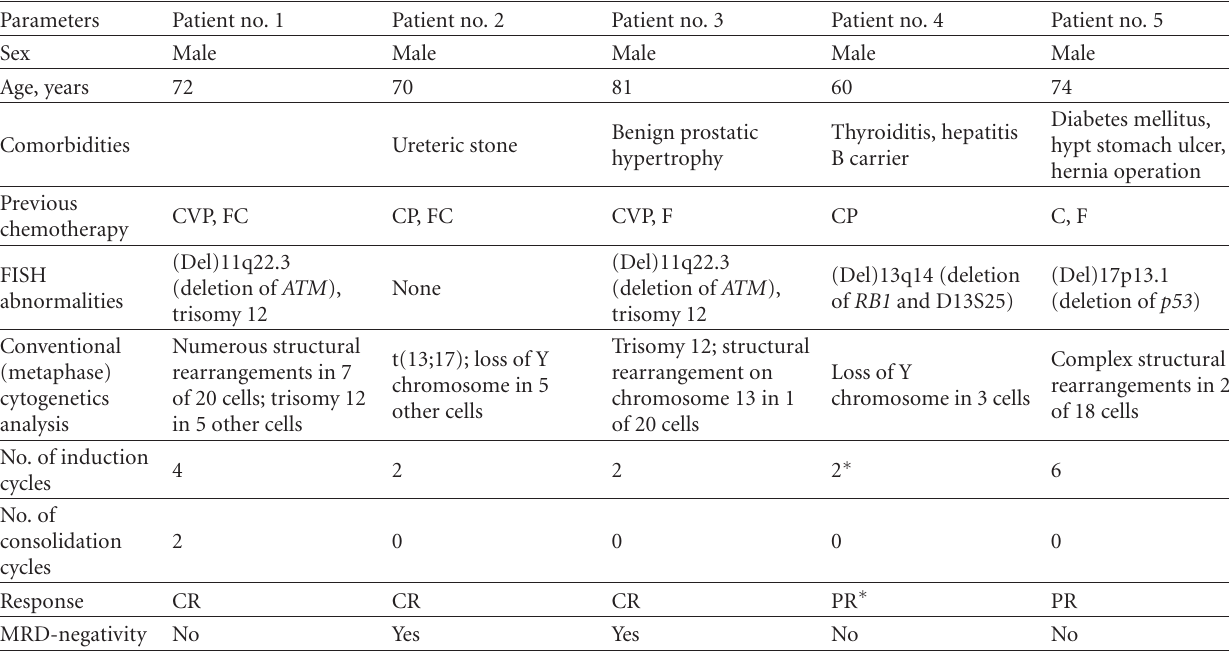
Table 1: Patient characteristics, treatment duration, and